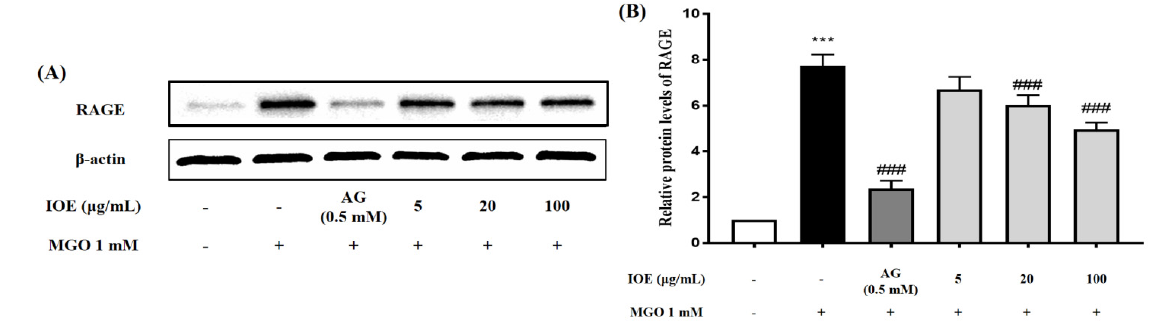
Figure 5. Effects of IOE on RAGE protein expression in MGO − induced mouse glomerular mesangial cells. Cells were pretreated with IOE for 1 h, followed by incubation with 1 mM MGO for 24 h. The protein expression levels of RAGE were measured using Western blots ( A ). RAGE band intensity; β -actin was used as an internal control ( B ). Each experiment was performed three times independently. Bar values are presented as mean ± standard deviation ( n = 3) (*** p < 0.001 vs. normal group and ### p < 0.001 vs. MGO − treated group).